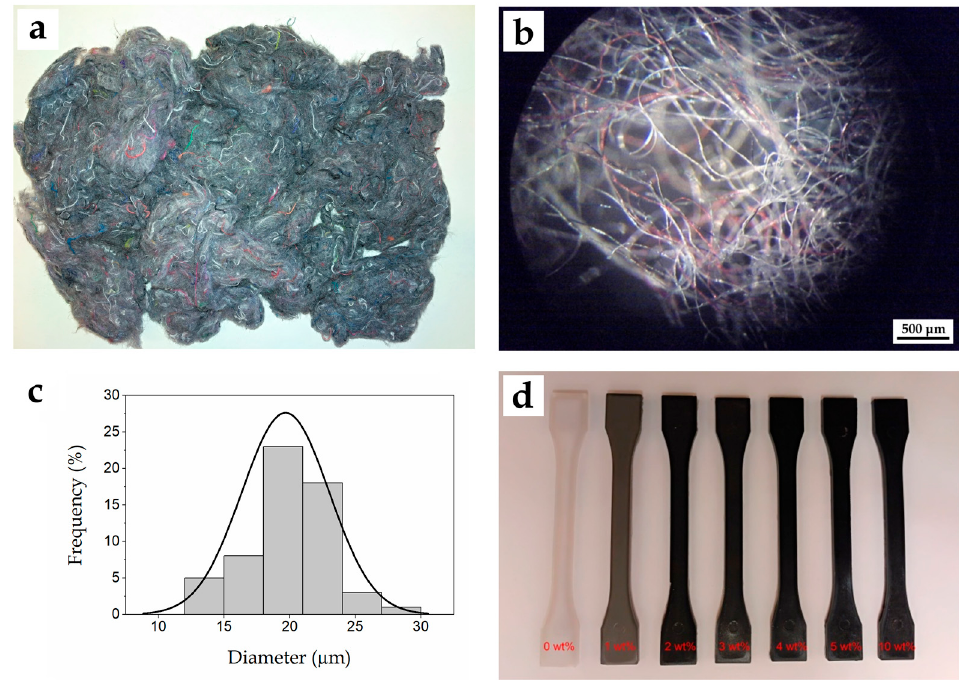
Figure 1. ( a ) As-received linter of recycled cotton; ( b ) optical microscopy image of recycled cotton fibers (RCFs) taken at 50× with scale marker of 500 μ m; ( c ) fiber diameter histogram of RCF; ( d ) injection-molded pieces of bio-based polyethylene terephthalate (bio-PET) at different RCF contents. Table 1. Color coordinates by CIElab color space ( L * a * b *) and density of the bio-based polyethylene terephthalate (bio-PET)/recycled cotton fiber (RCF) composite pieces. L* Code Bio-PET100